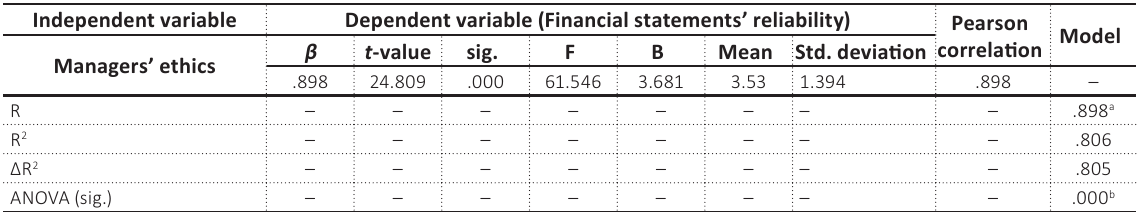
Table 5. Linear regression analysis for H